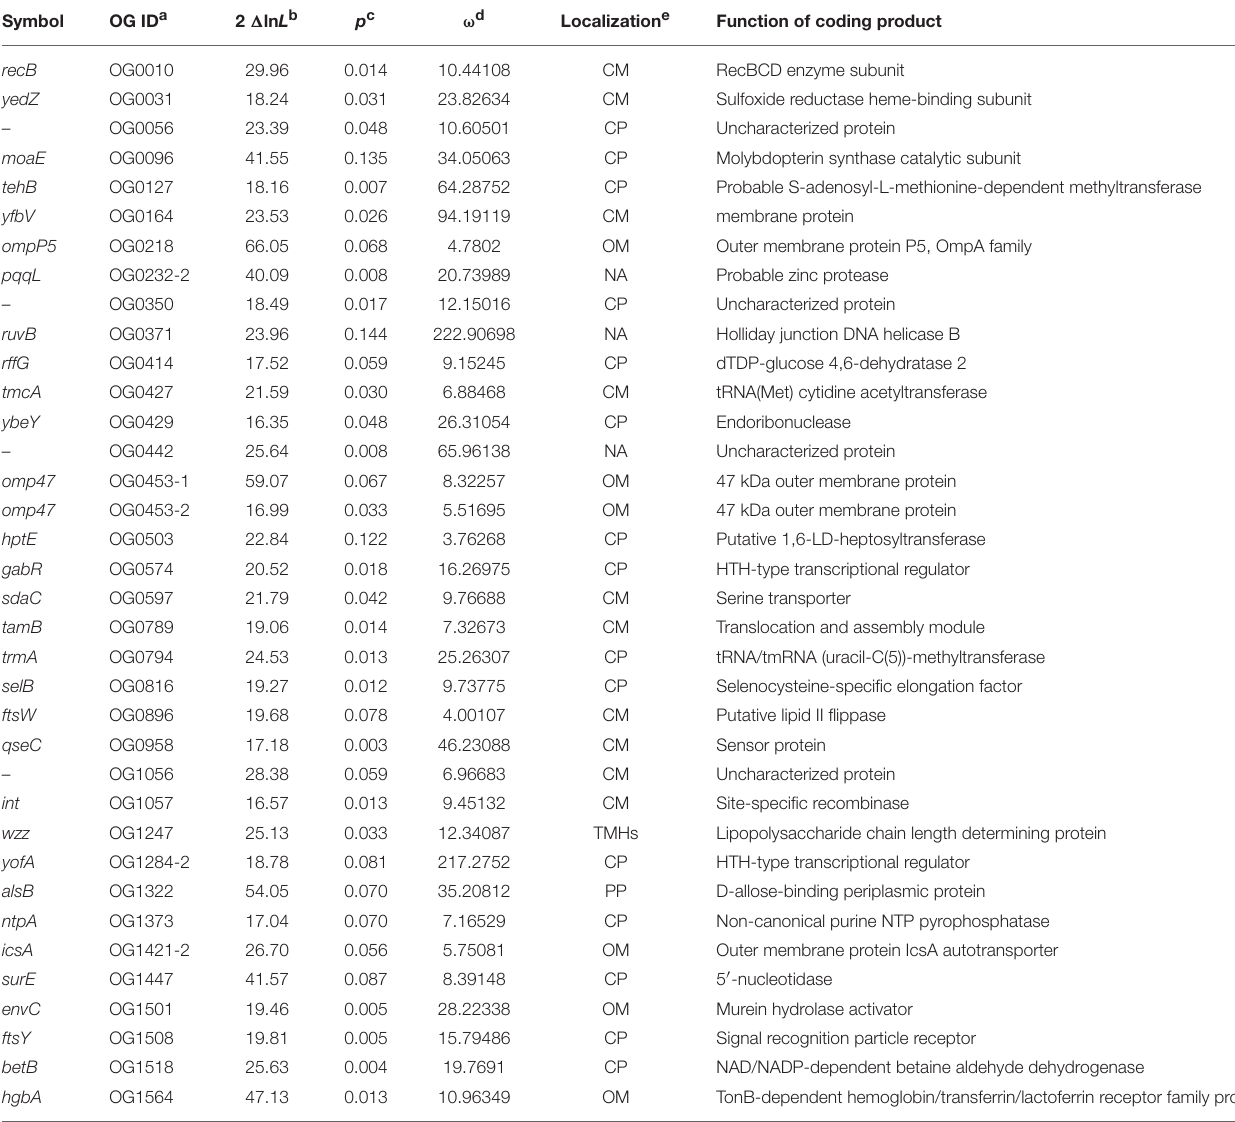
TABLE 3 | P. multocida genes that show evidence for positive Darwinian selection.